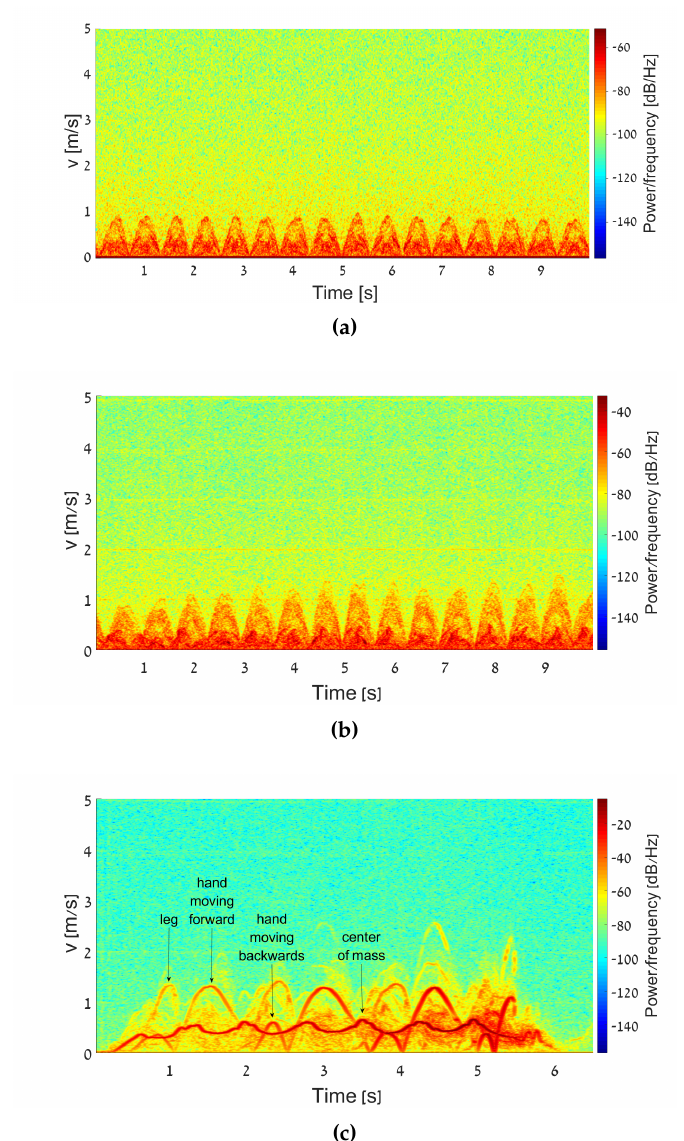
Figure 6. Human motion spectrogram: ( a ) Hand motion alone. ( b ) Leg motion alone. ( c ) Normal human walking.